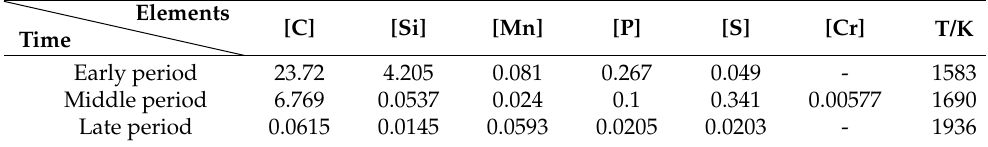
Table 6. Activities of elements in molten steel in different melting periods.